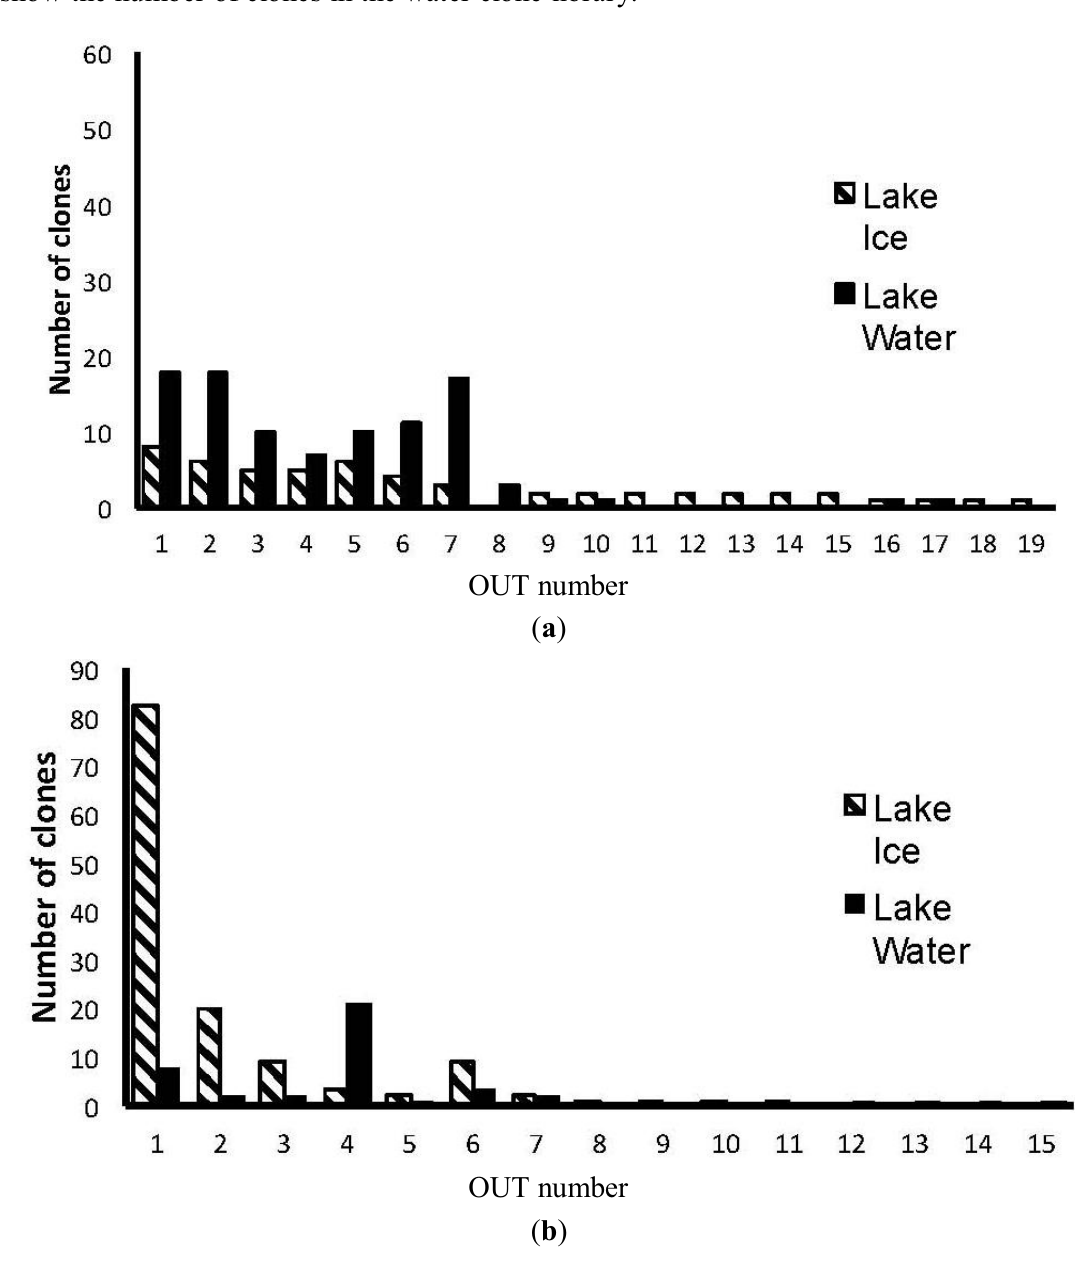
Figure 5. Rank-abundance curves for: ( a ) bacteria; and ( b ) Eukarya clone libraries. Operational taxonomic units (out) were numbered in order of total number of clones in both libraries. Hatched bars show the number of clones in the ice clone library; solid bars show the number of clones in the water clone